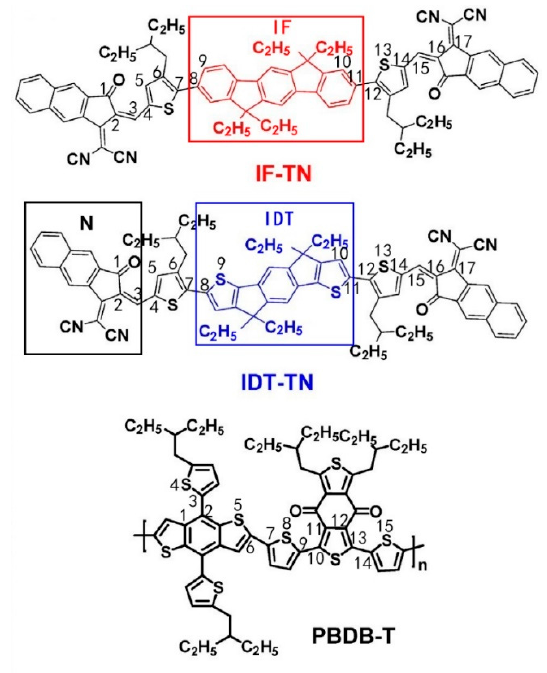
Figure 1. Molecular structure of the non-fullerene acceptors (NFAs) IF-TN, IDT-TN and donor PBDB-T.